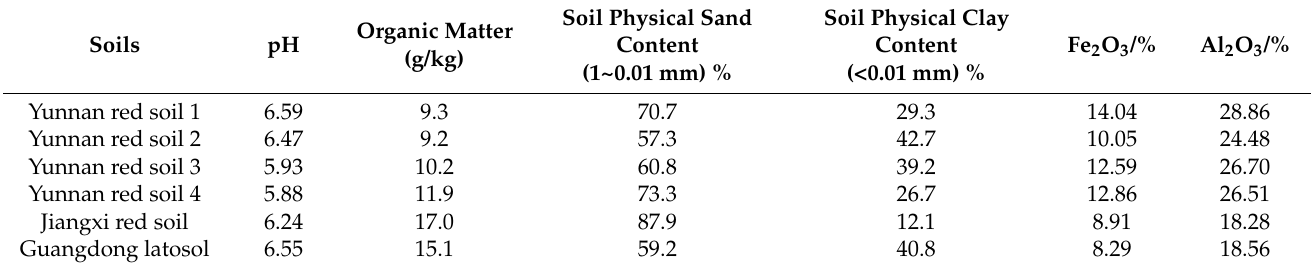
Table 1. The Essential Physiochemical Properties of Six Typical